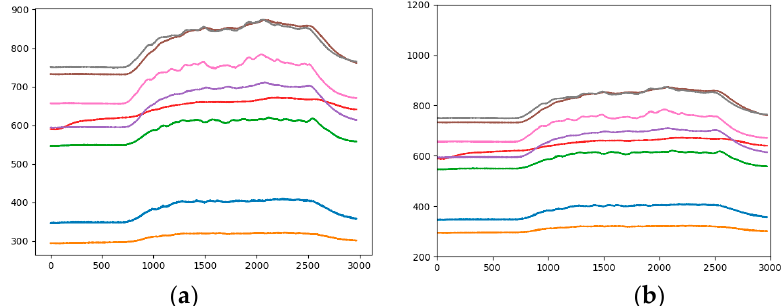
Figure 3. A sample of analogous-image ( a ) High concentration of Methane; ( b ) Low concentration of Ethylene.